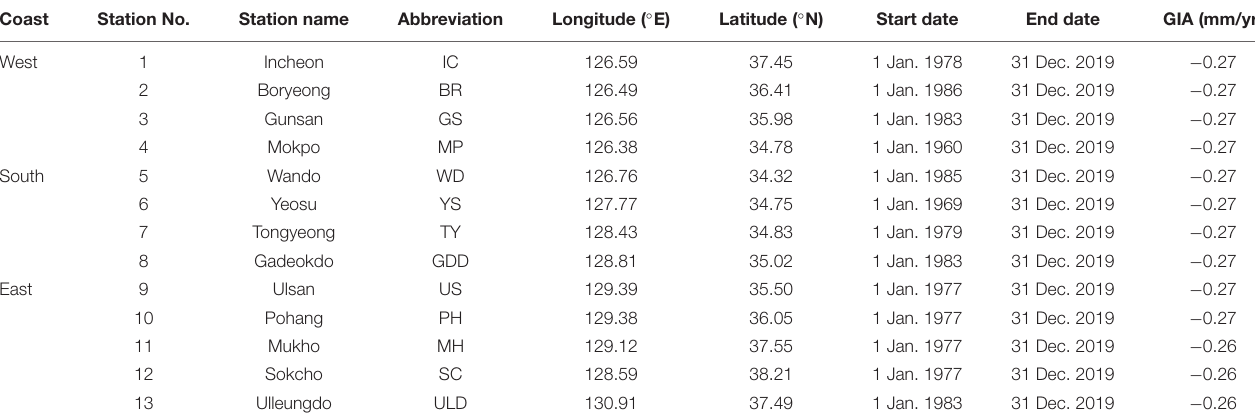
TABLE 1 | Locations, names, start and end dates, and relative sea level changing rates due to glacial isostatic adjustment (GIA) of TG sea level stations/records used in this study. Coast Station